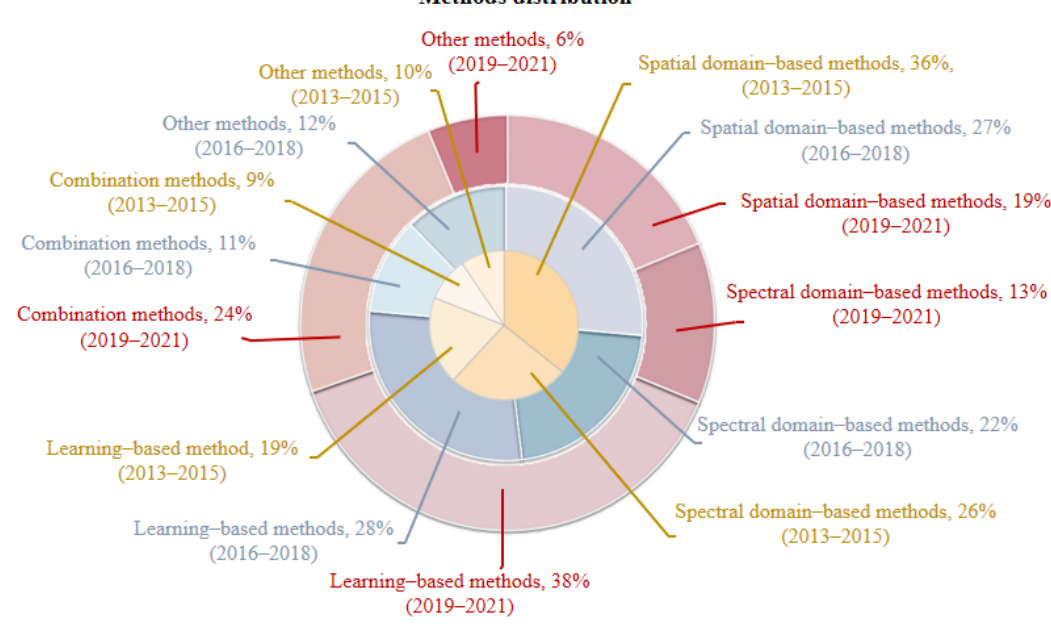
Figure 8. Distribution of evaluation methods.